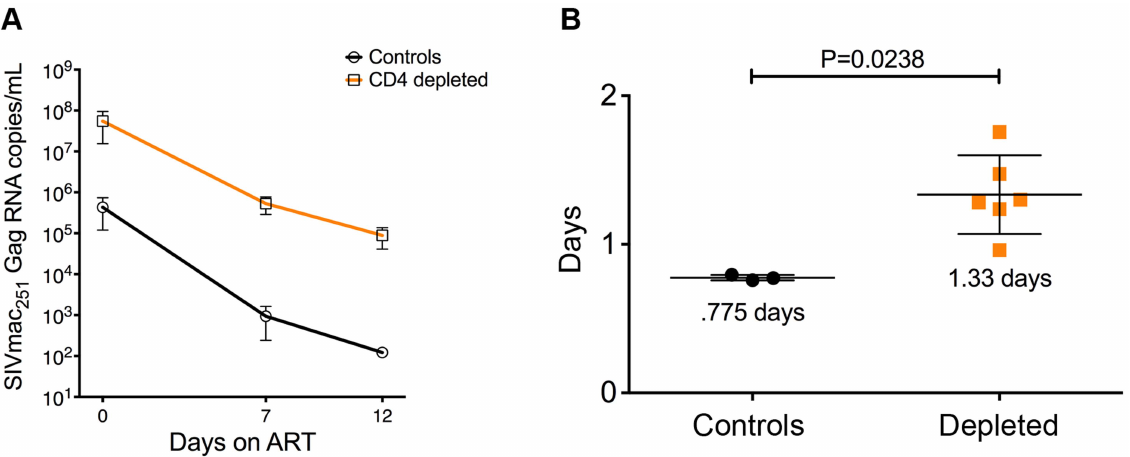
Figure 6. Viral decay kinetics in CD4-depleted and control RMs. ( a ) Longitudinal levels (mean 6 S.E) of viral load, expressed as number of SIVmac251Gag RNA copies per mL of plasma, in ART-treated CD4-depleted (orange square; n=6) and undepleted control (closed circle; n=3) RMs. Viral load was assessed at ART-initiation (day 0) as well as at day 7 and day 12 on-ART. ( b ) In vivo lifespan of the predominant population of productively infected cells was estimated for CD4-depleted and undepleted control RMs based on the viral load changes between day 0 and day 7 (although the same conclusions were reached if we included day 12) showed in ( a ). Two CD4-depleted RMs were sacrificed before day 7 on-ART (one at day 3 and one at day 6 on-ART; see Table S1); thus, the graph includes the six CD4-depleted animals for which data were available at day 7